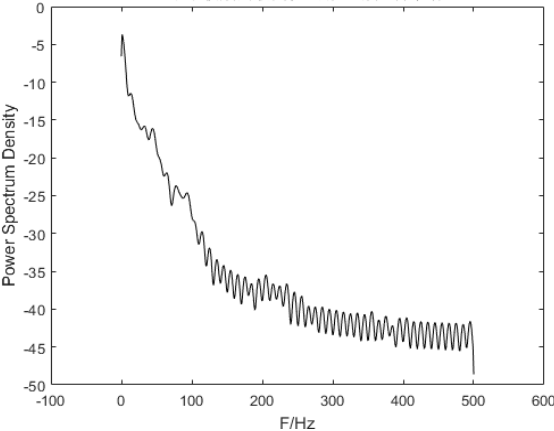
Figure 10. 1/ f Noise power spectral density detected by the VMD algorithm.